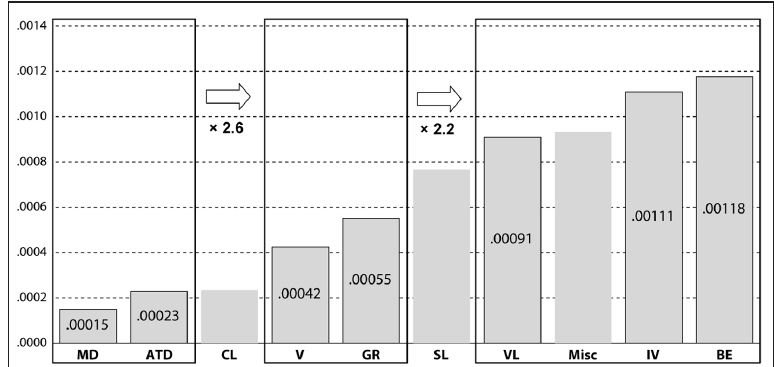
Figure 3: Groups of major novels according to density of musical references